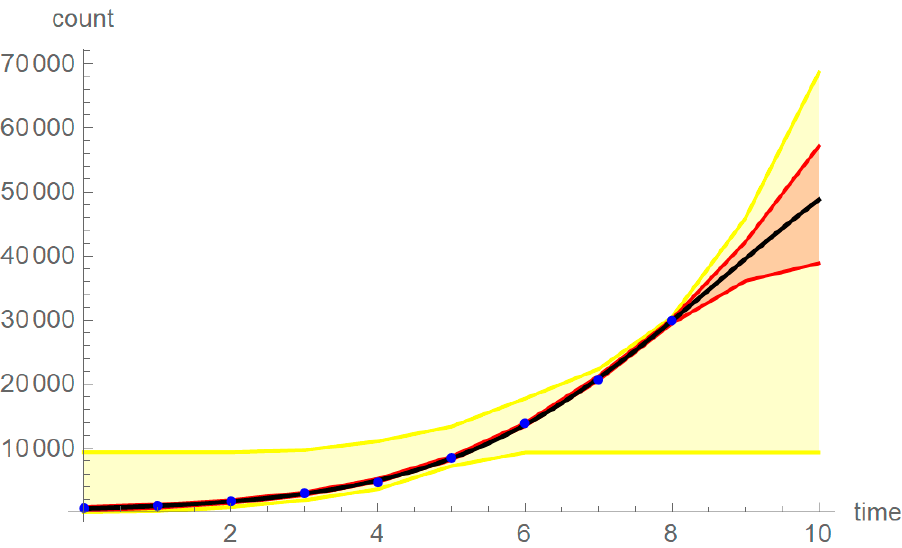
Figure 2. Stock of electric cars in Austria during 2011–2019. Note: stock data (blue dots), best-fit growth curve (black) with the best-fit exponents of Table 2, band of growth curves with an Akaike weight of 5% or higher (red), and band of the best-fit growth curves using any exponent pair from the search grid (yellow); plot using Mathematica 12.1.